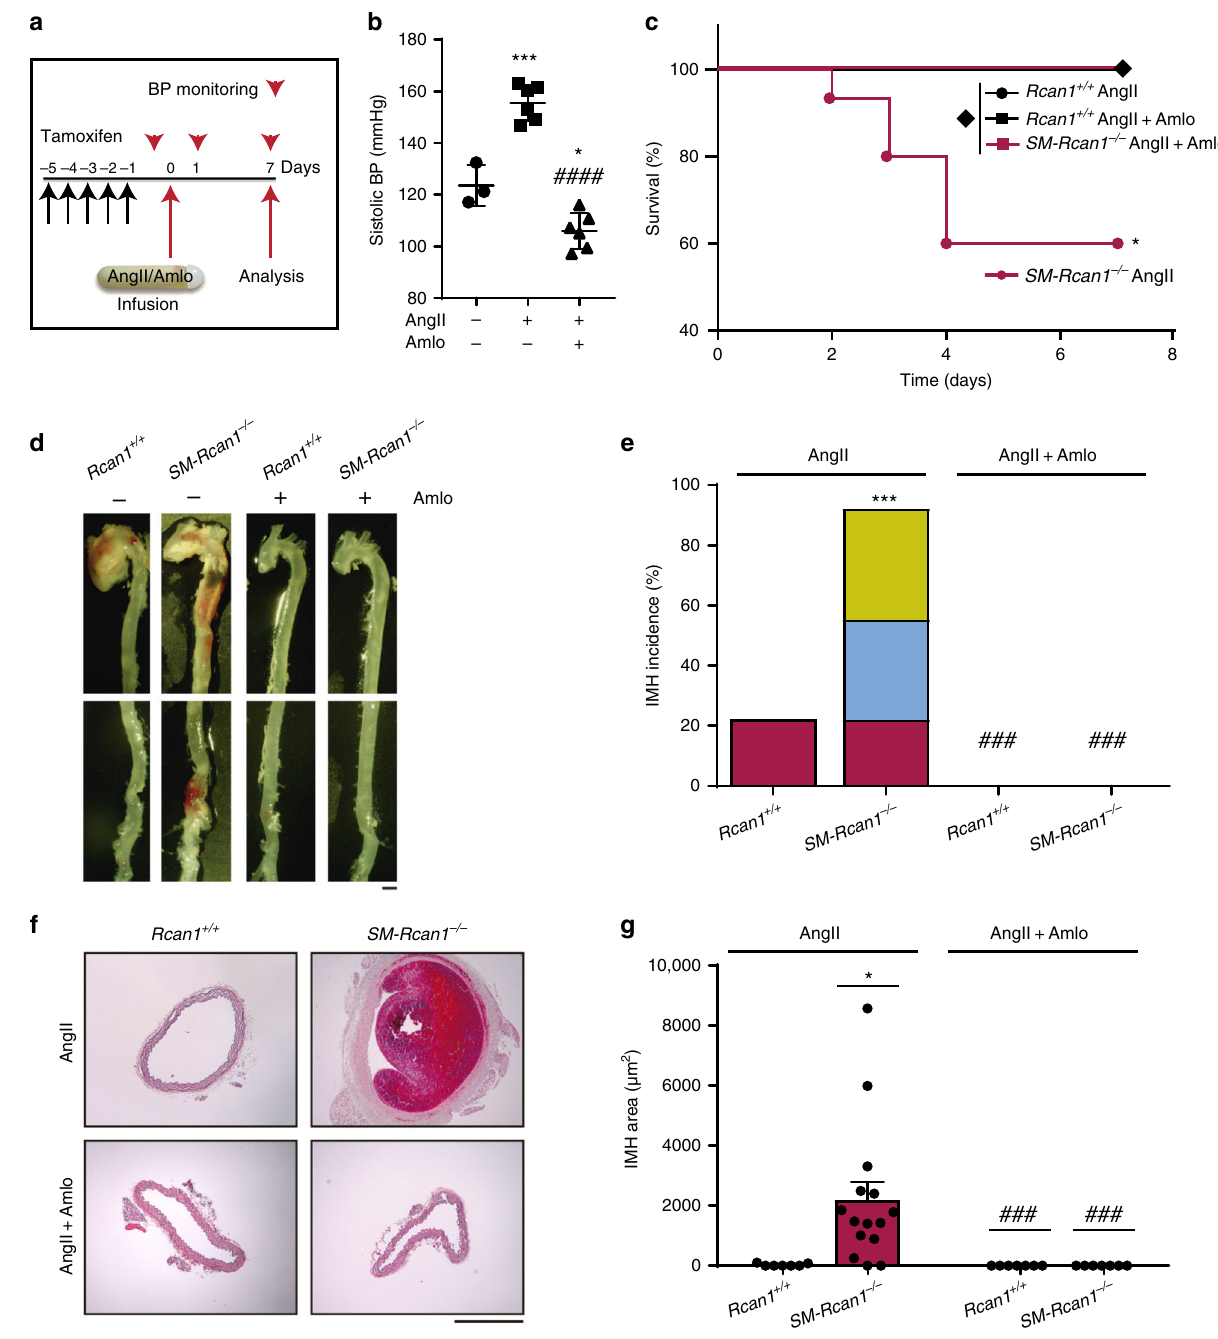
Fig. 4 The hypertensive effect of AngII is required for IMH formation. a Experimental design: 6 – 8-week-old male mice were treated with tamoxifen for 5 consecutive days (black arrows) before the implantation of osmotic minipumps for infusion of AngII (1 μ g kg − 1 min − 1 ) and amlodipine (Amlo, 6 mg kg − 1 day − 1 ). Mice were monitored for blood pressure (BP; red arrowheads) and euthanized at the end of the experiment. b Systolic BP measurements in Rcan1 + / + mice treated with saline ( n = 3), AngII ( n = 6), or Amlo plus AngII ( n = 6). One-way ANOVA with Tukey multiple comparison post-hoc test, *** p < 0.001, * p < 0.05 vs. untreated, ### p < 0.001 vs. AngII. c Survival curve of Rcan1 + / + and SM-Rcan1 − / − mice treated with AngII and Amlo as indicated. Log-rank (Mantel-Cox) test, * p < 0.05 vs. Rcan1 + / + AngII. All deaths were due to aortic rupture. d Representative images of macroscopic hematomas in aortas from mice treated with AngII or AngII + Amlo (scale bar, 1 mm) and e hematoma incidence in these mice. Chi-square distribution, *** p < 0.001 vs. Rcan1 + / + AngII, ### p < 0.001 vs. SM-Rcan1 − / − AngII. f Hematoxylin-eosin staining of AbAo cross-sections from the same mice (scale bar, 500 µ m) and g IMH area quanti fi cation in these sections shown as mean + s.e.m; each data point denotes an individual mouse. Rcan1 + / + AngII ( n = 8), Rcan1 + / + AngII